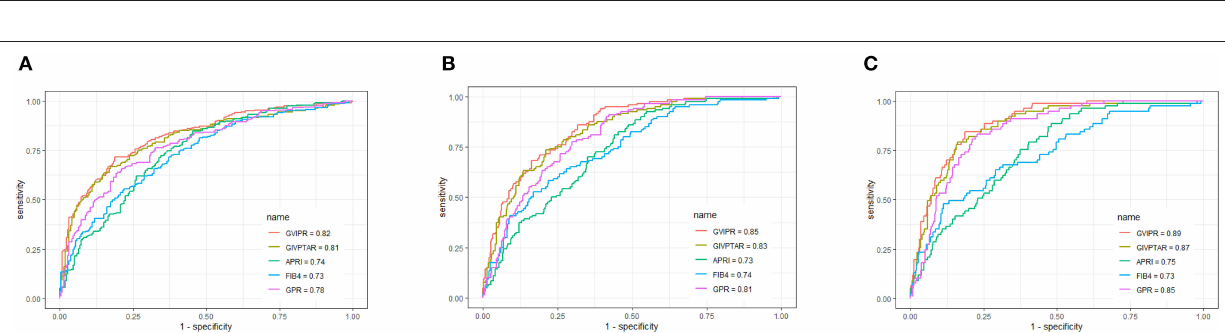
GIVPR had the highest AUC (0.81, sensitivity 68.95%